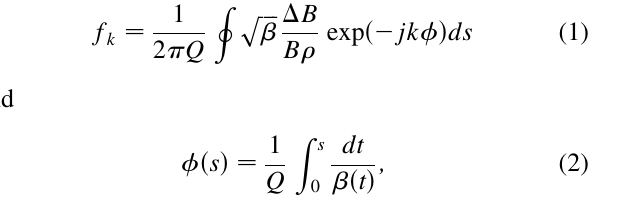
FIG. 4. Distribution of maximum horizontal orbit distortion out of 501 different gradient errors.